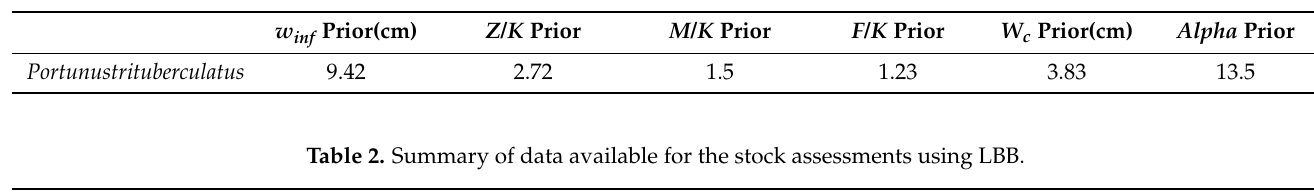
Table 1. Priors of the P. trituberculatus given by LBB.